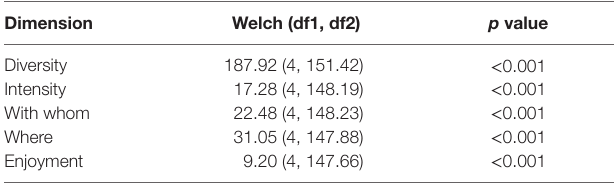
TaBle 3 | group differences in activity type by dimension. TaBle 2 | all activities categorized by activity type in order of frequency.